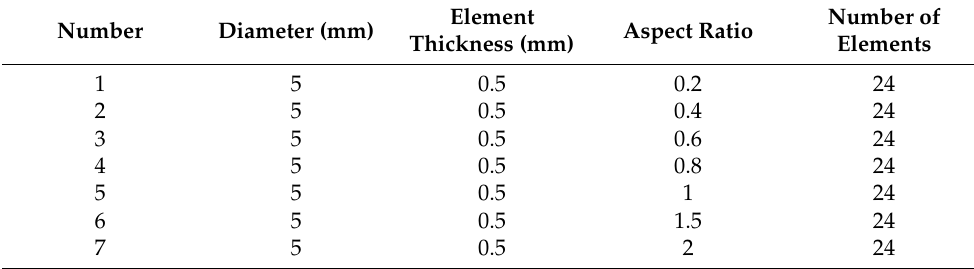
Figure 1. Schematic of six ‐ element Kenics static mixer with aspect ratio of ( a ) 0.4; ( b ) 1.0. Table 1. Dimensions of the Kenics static